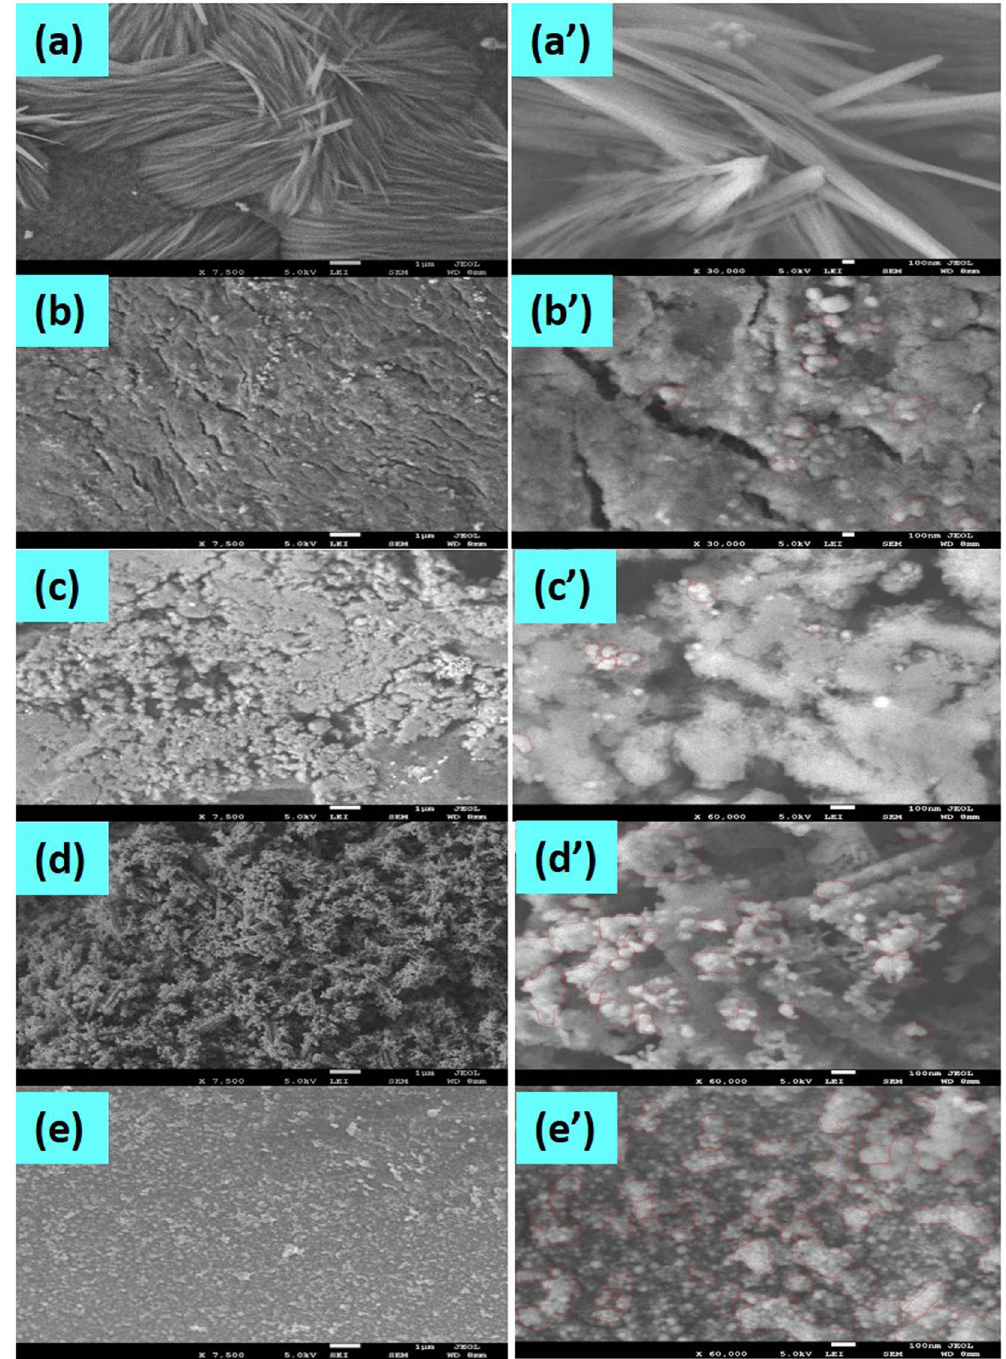
Figure 4. FESEM images of pure CS-TiO 2 fibers ( a , a’ ), Cu/CS-TiO 2 -15 ( b - b’ ), Co/CS-TiO 2 -15 ( c - c’ ), Ag/CS- TiO 2 -15 ( d - d’ ) and Ni/CS-TiO 2 -15 ( e - e’